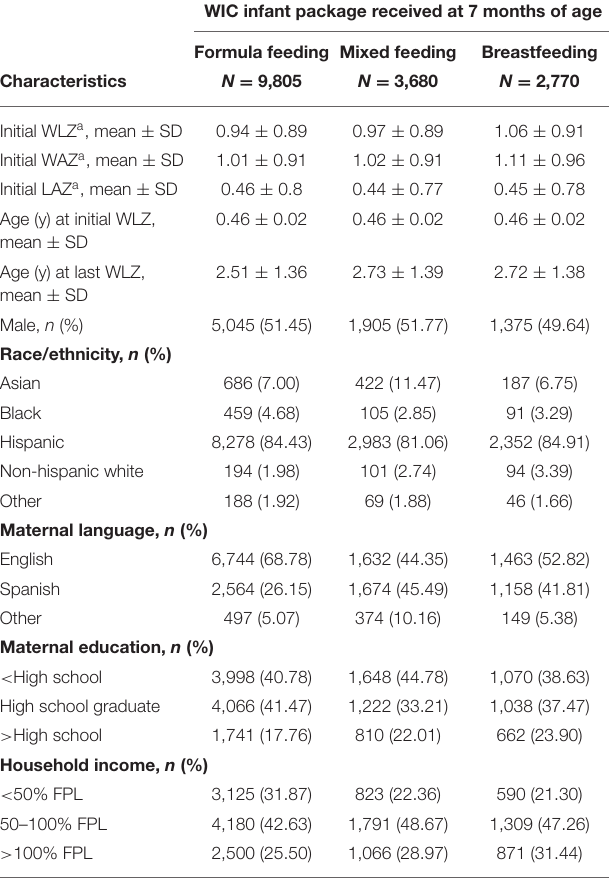
TABLE 1 | Characteristics of WIC-participating children in Southern California, 2009-2019, by WIC infant package received at 7 months ( N =